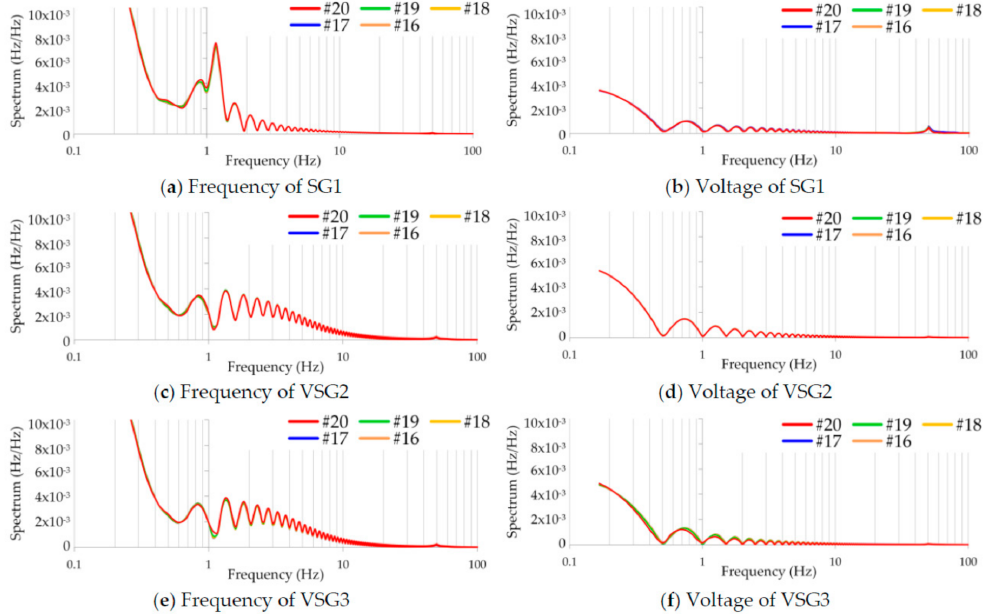
Figure 11. DFT analysis of the system frequency/voltage for tests 16–20 in Table